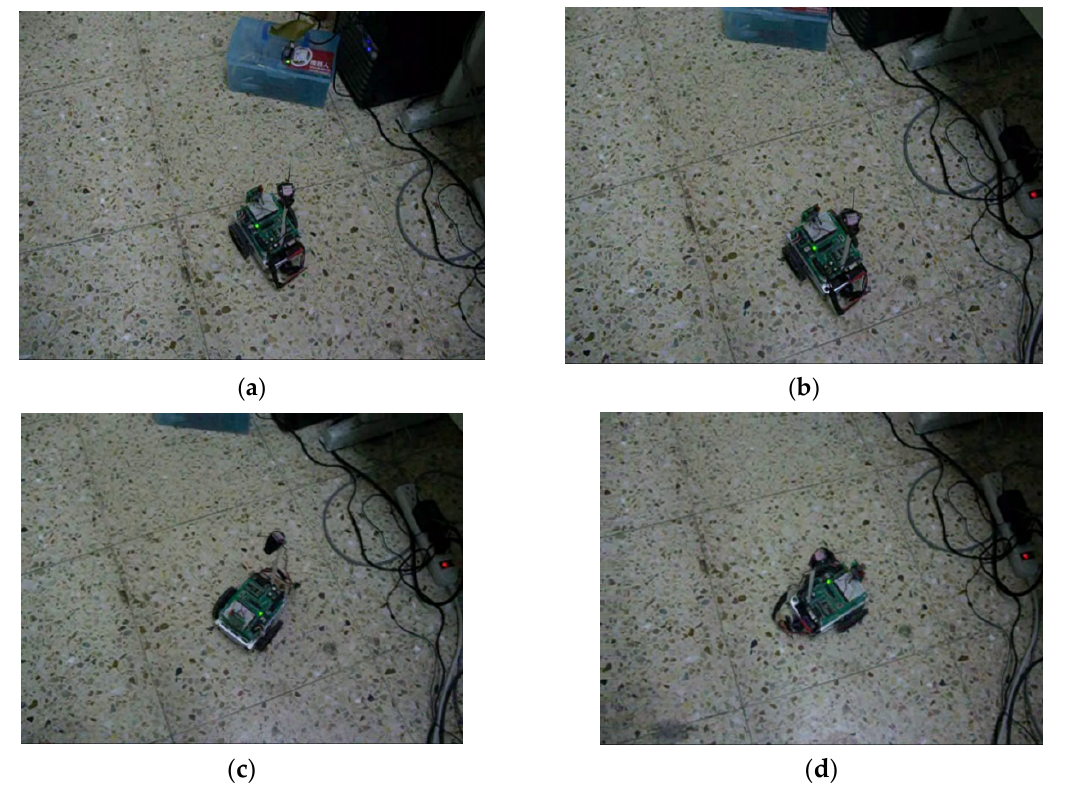
Figure 29. Remote operation. ( a ) Forward operation; ( b ) Backward operation; ( c ) Left ‐ turn operation; ( d ) Right ‐ turn operation.